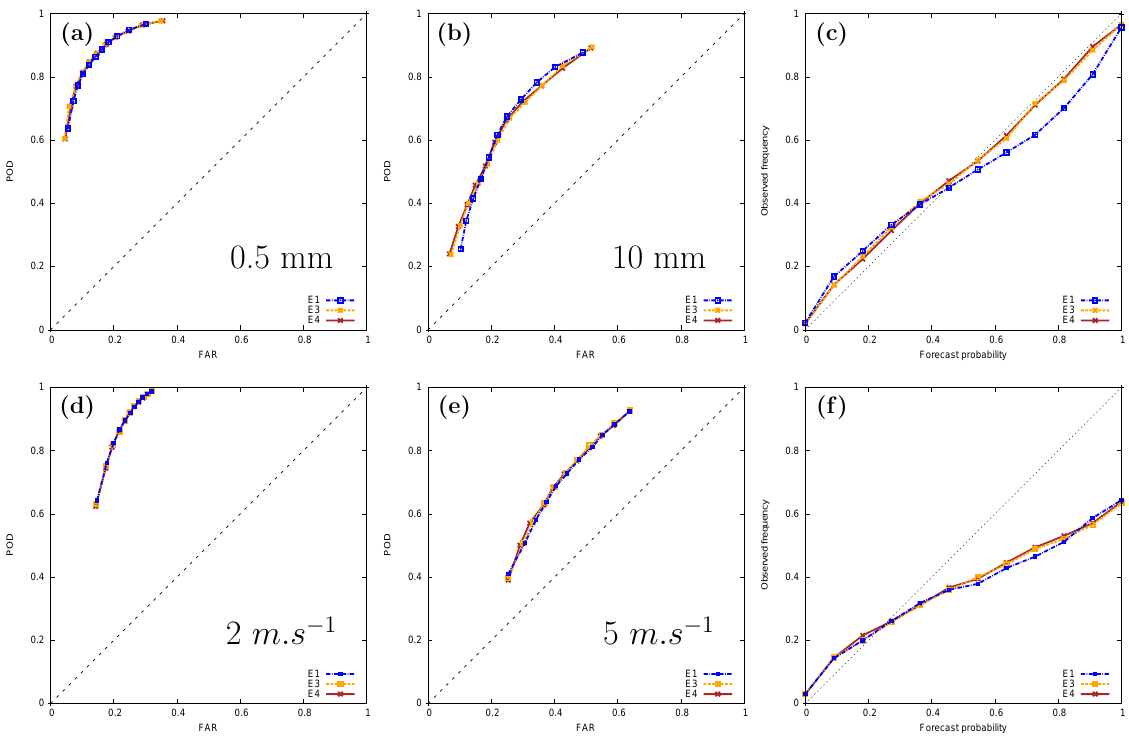
Fig. 4. ROC curves for precipitation thresholds of (a) 0.5 and (b) 10mm and for 10-m wind speed thresholds of (d) 2 and (e) 5ms − 1 . Reliability diagrams for (c) precipitation and (f) 10-m wind speed.